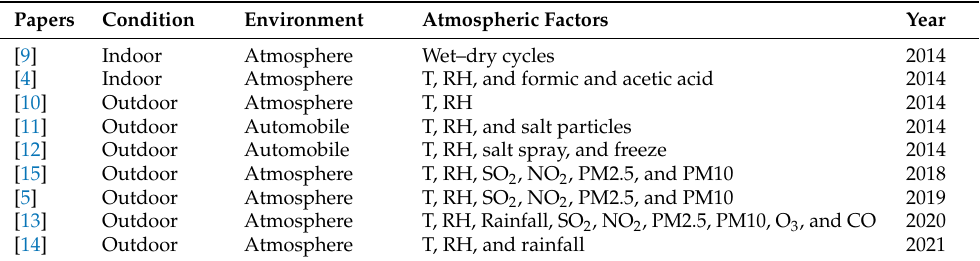
Table 1. Summary of some related works with ACM